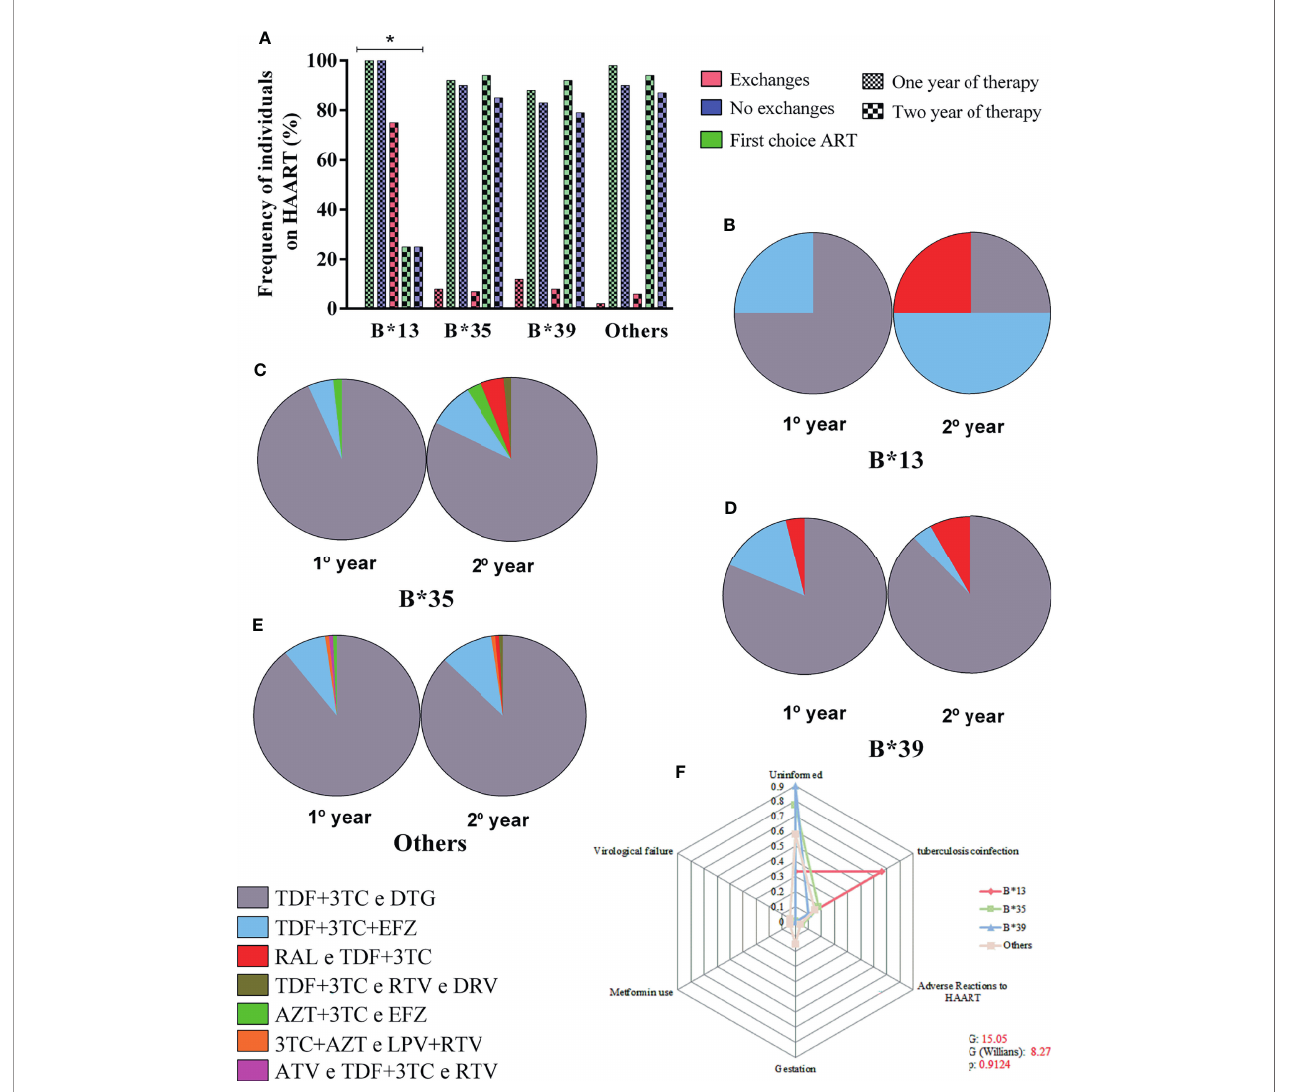
FIGURE 5 | (A) Frequency plot of the rate of maintenance of therapeutic regimens among carriers of alleles B*13, B*35, B*39 and other alleles in the 24-month period; the treatment switching rate was associated with allele B*13; * : 0.05 ≤ p > 0.0001. (B – E) Diversity of therapeutic regimens administered in 1- and 2-year periods in carriers of alleles B*13 (B) , B*35 (C) , B*39 (D) and other alleles (E) . (F) Radar chart showing the reasons for switching therapy between carriers of alleles B*13, B*35, B*39 and other alleles; each equiangular spoke represents a reason for switching therapy; approximately 66% of B*13 allele carriers switched treatments due to coinfection with tuberculosis. TDF, tenofovir; 3TC, lamivudine; DTG, dolutegravir; EFZ, efavirenz; RAL, raltegravir; RTV, ritonavir; DRV, darunavir; AZT, zidovudine; LPV,